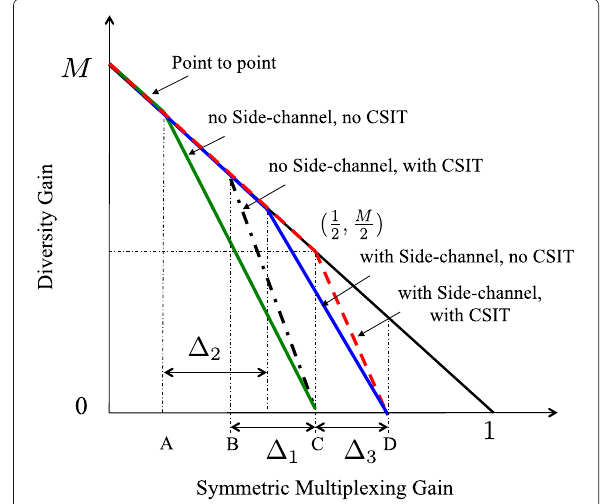
Fig. 10 DMT comparison w/wo side-channel w/wo CSIT when , α S = M W = 1 2 M + 1